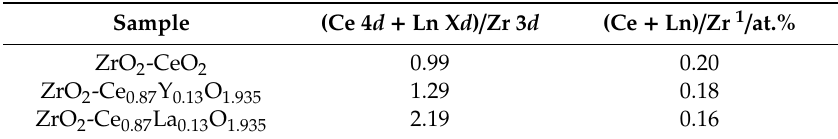
Table 2. XPS quantitative results for the fresh undoped and Ln-doped ZrO 2 -CeO 2 samples.